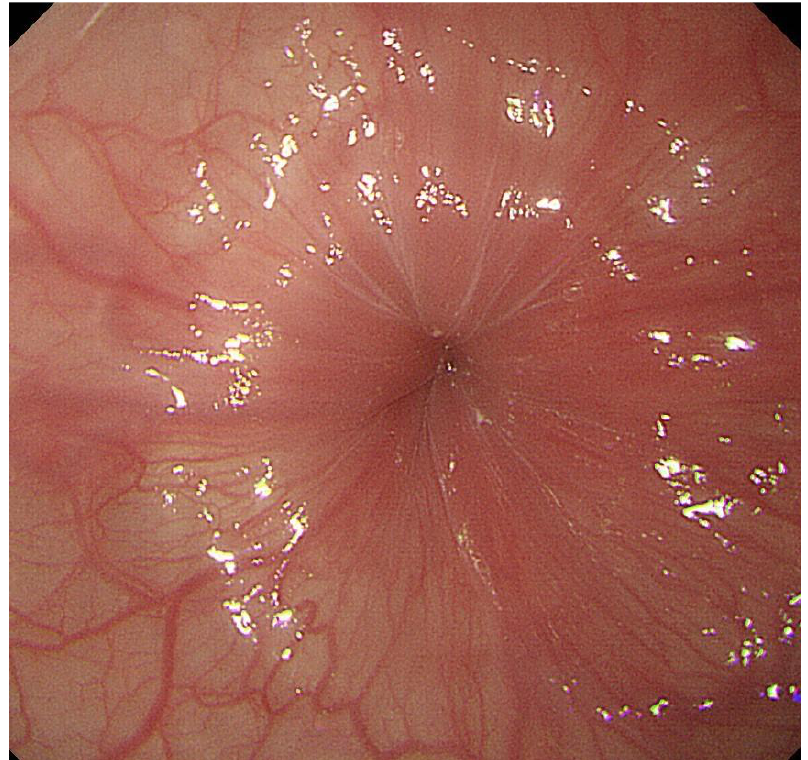
Figure 1. A case in which esophageal rosette was observed. Rosette-like appearance was observed at the esophago-gastric junction during deep inspiration.